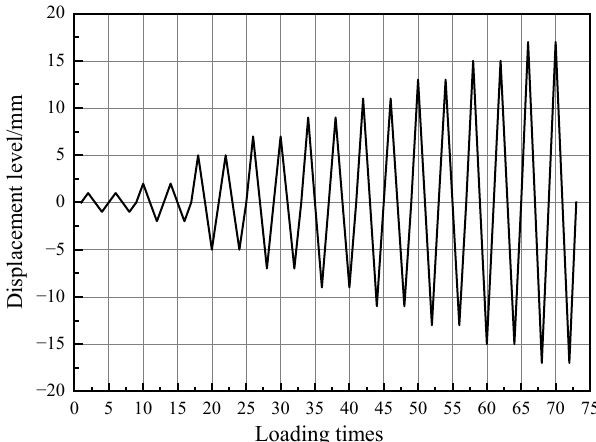
Figure 8. Loading procedures for the specimens.